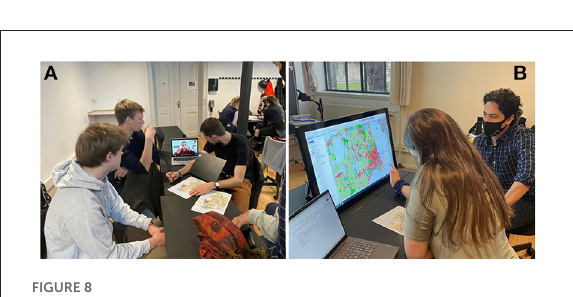
FIGURE8 (A) Participants of one group propose scenarios on printed maps as an online participant co-discusses this scenario, and (B) participant applies the proposed scenario on the